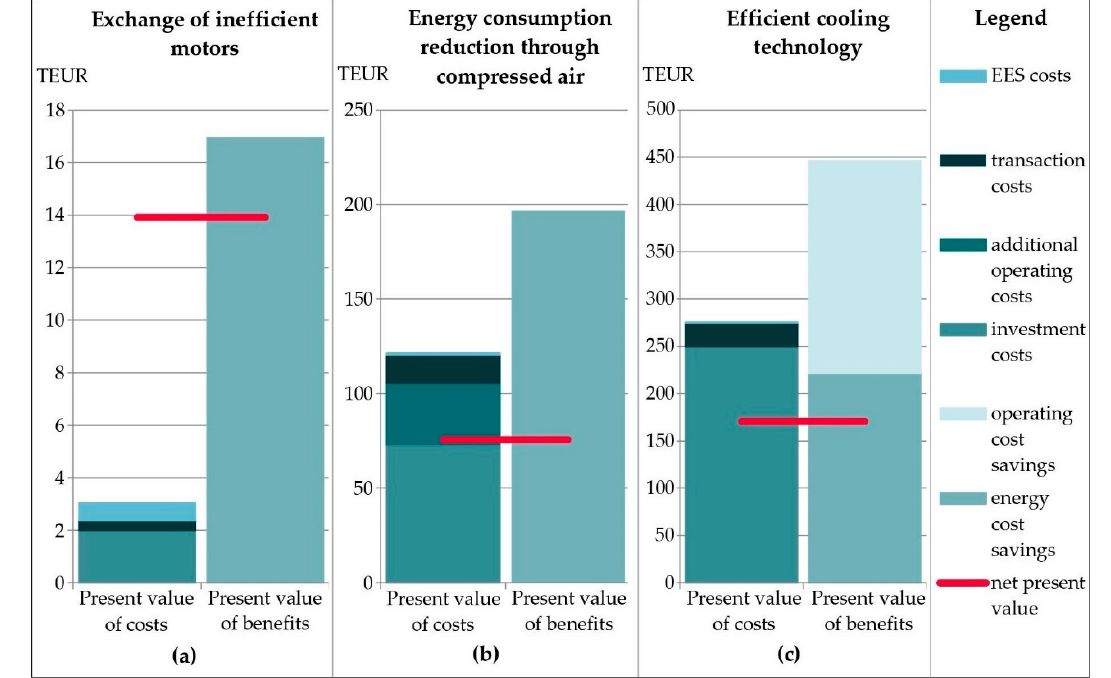
Figure 2. Enhanced dynamic cost–benefit analysis of the selected energy efficiency measures: ( a ) M1, ( b ) M2, and ( c ) M3, with EES costs to investor (after government subsidies using a 2.00% discount factor).